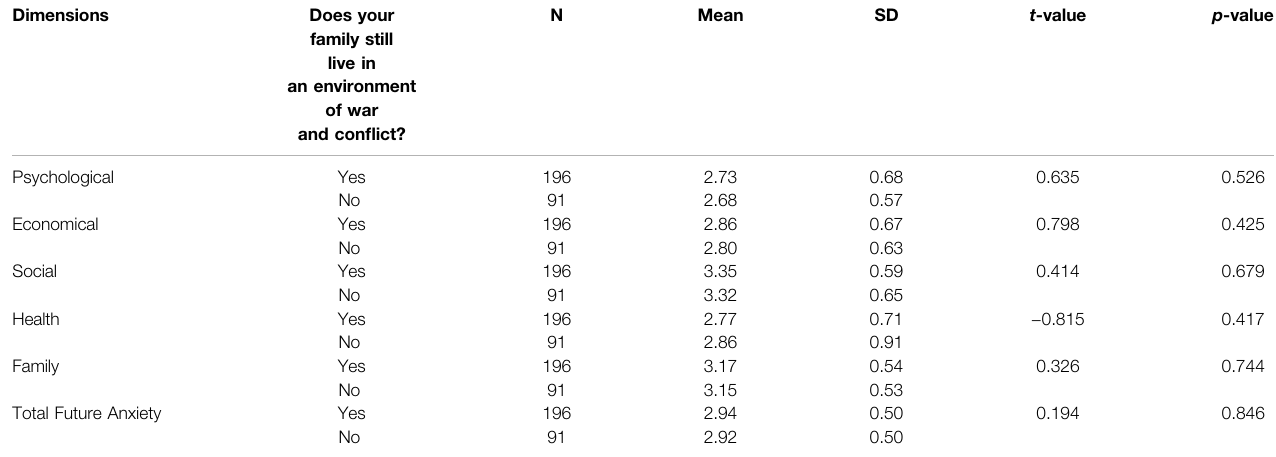
TABLE6| Thebelowtableshowsthedifferencesbetweenthosewhohavefamilywhostilllivesinanenvironmentofwarandcon fl ictandthosewhohaven ’ t,intermsoffuture anxiety and its dimensions.